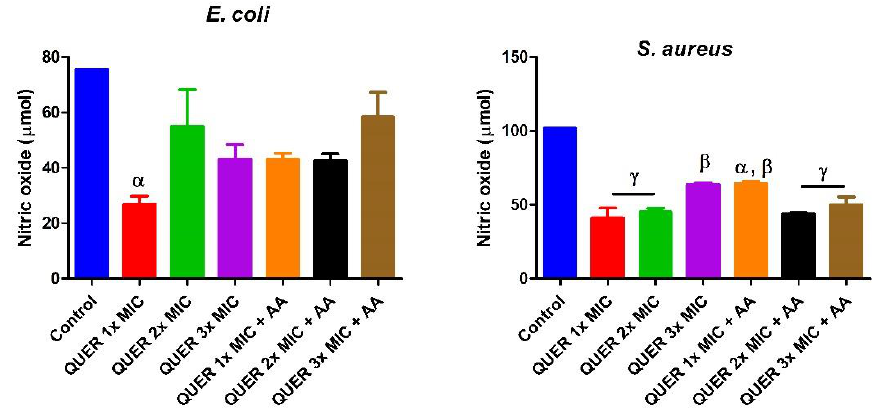
Figure 3. Concentration of nitric oxide in bacterial isolates following exposure to quercetin (QUER) alone or when combined with ascorbic acid (AA). Results are presented as an average of duplicate biological experiments (n = 2) with the corresponding error of the mean (SEM). Relative to the control or QUER 1 × MIC, α at p < 0.05 is significant, β at p < 0.01 and γ at p <